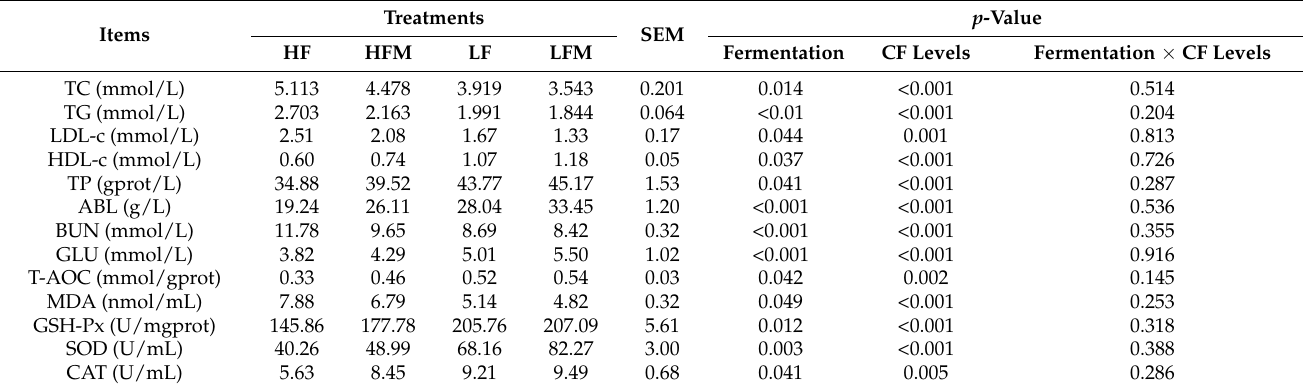
Table 5. Effects of multi-bacteria fermentation and dietary CF level on serum biochemical parameters in finishing pigs.